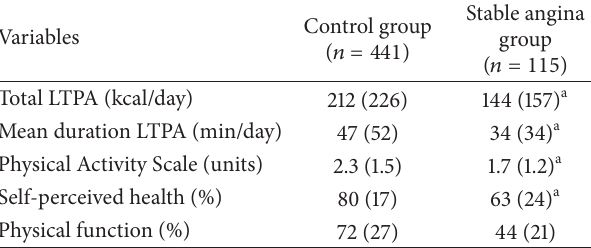
Table 2: Measures of physical activity and quality of life in patients with chronic stable